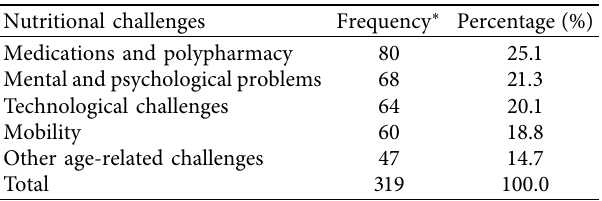
Table 5: Nutritional challenges faced by respondents in meeting their food needs. Nutritional